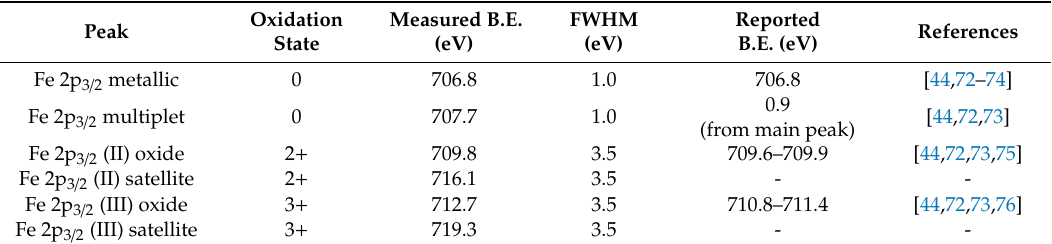
Table 13. B.E. values for